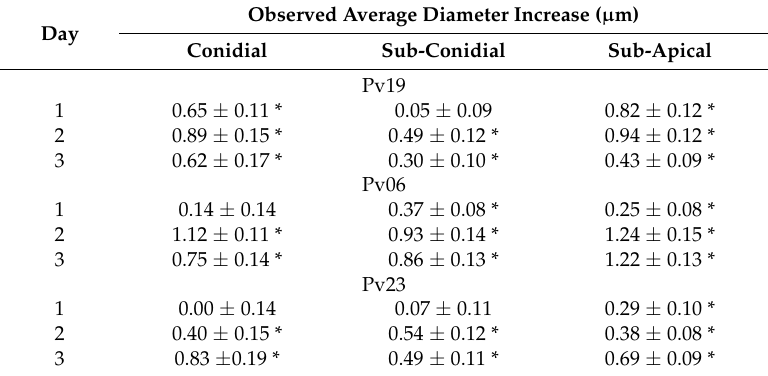
Table 3. Average conidial, sub-conidial, and sub-apical diameter increases in A. striata treated Pv19, Pv06, and Pv23 when compared to controls. Experiments were performed with three replicates on three separate days. Observed Average Diameter Increase (µm) Day Conidial Sub-Conidial